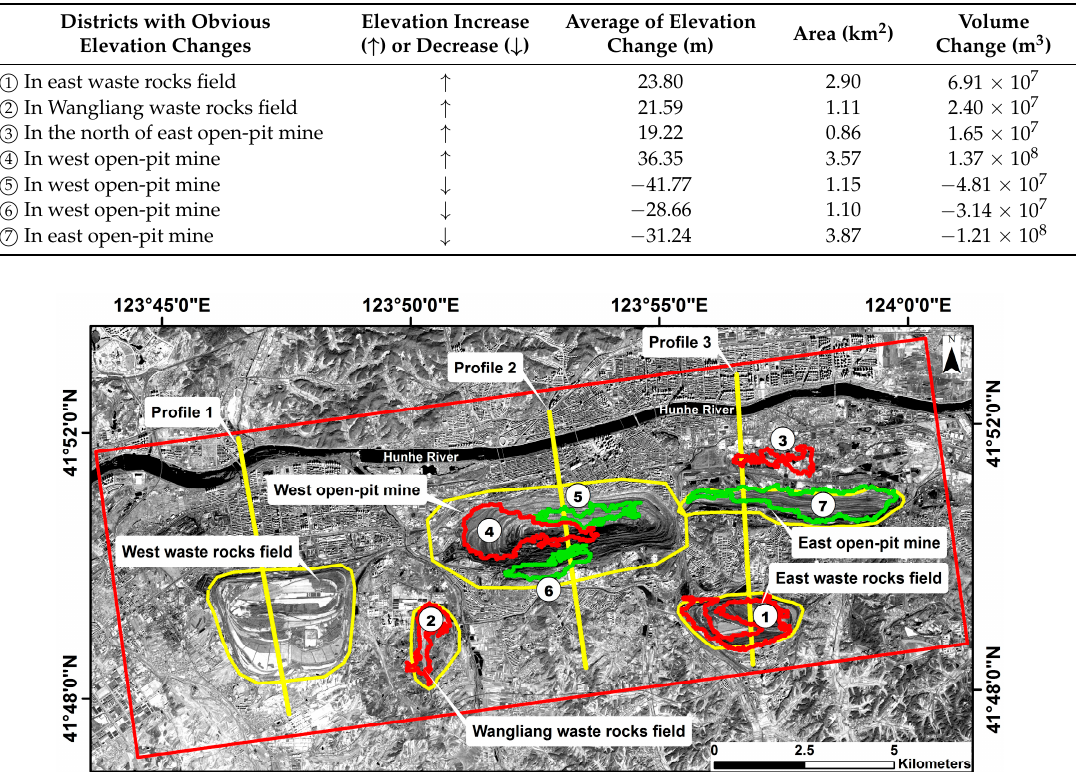
Table 6. Results of the deformation areas with obvious elevation changes using ZY-3 DSM in 2015 and ASTER GDEM.